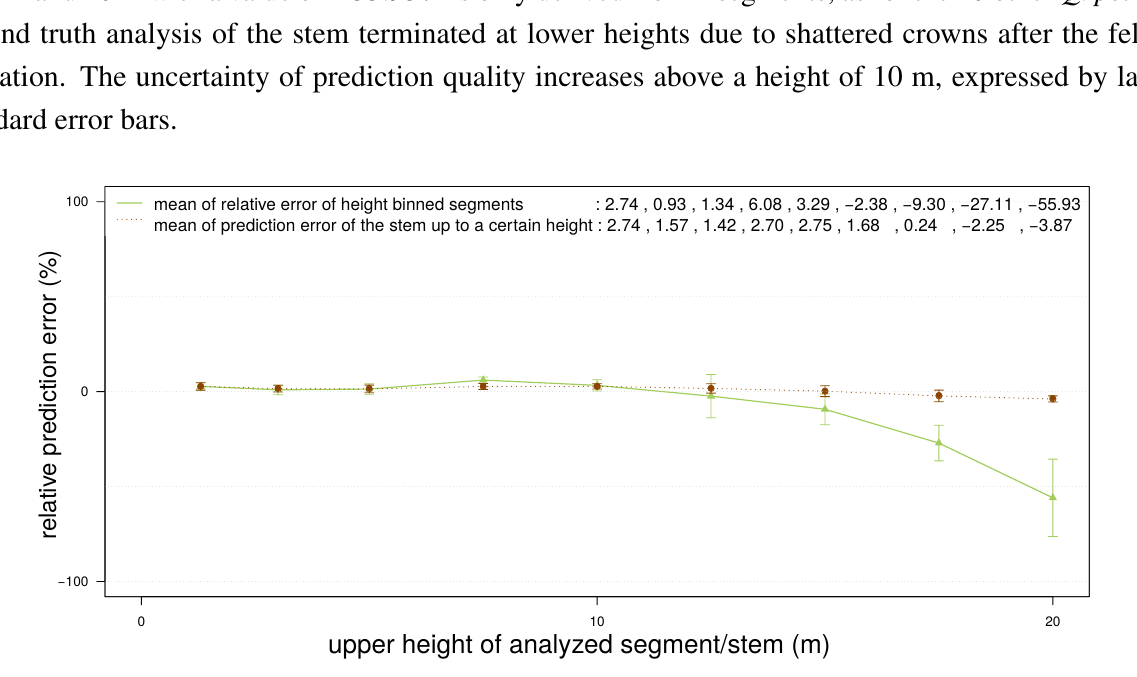
Figure 6. Prediction quality analyses of the stem of 12 Q. petraea . The green graph describes the averaged prediction error for all segments taken from the same height. The brown graph represents the prediction error of the cumulative volume of all stem segments up to a certain height. Both graphs include the standard error in form of error